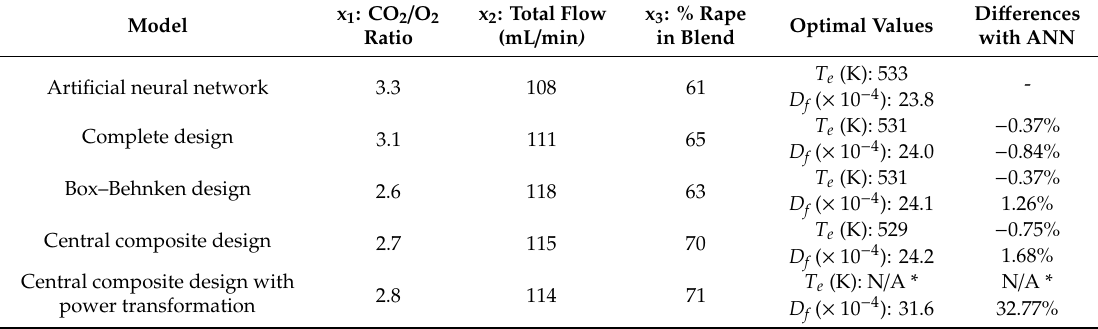
Table 6. T e and D f values at the optimal point conditions, as found by the five optimisation